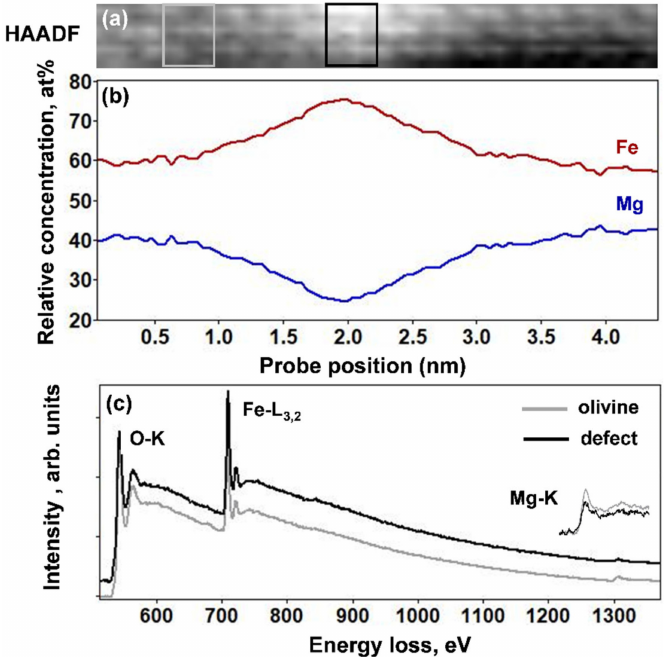
Figure 4. ( a ) Online HAADF image of thin (100) planar defect, comparable to the one shown in Figure 2b. ( b ) Relative concentration profiles of the Fe-L3,2 and Mg-K EELS edges. The EELS profiles show that this defect is enriched in Fe and depleted in Mg. ( c ) EELS spectra in the energy range between 500 and 1400 eV, where the O-K, Fe-L3,2, and Mg-K edges appear. The spectra were integrated over 60 pixels and extracted from the corresponding spectrum image from the places indicated by the boxes marked in ( a ). Gray box in ( a ) and gray line in ( c ) correspond to olivine and the black ones to the defect. In the inset of ( c ) a magnification on the Mg-K edge in between 1280 and 1340 eV is